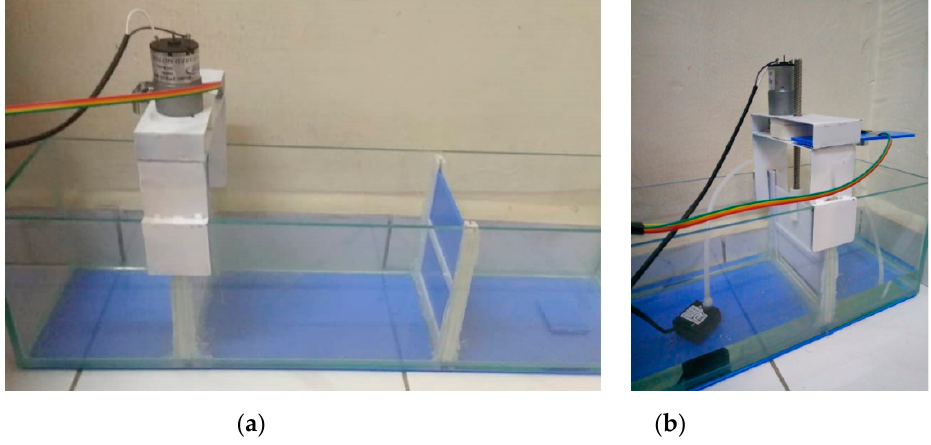
Figure 3. ( a ) Gate V2 vs. ( b ) the water test on Gate V2 with the water pump.